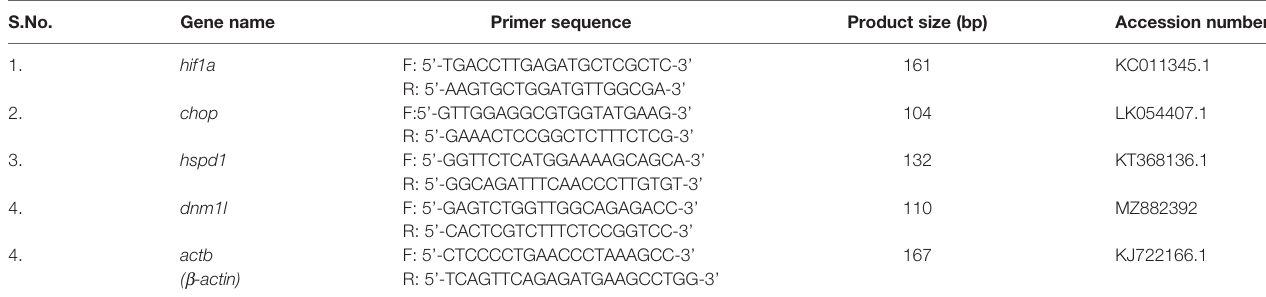
TABLE 2 | List of RT-qPCR